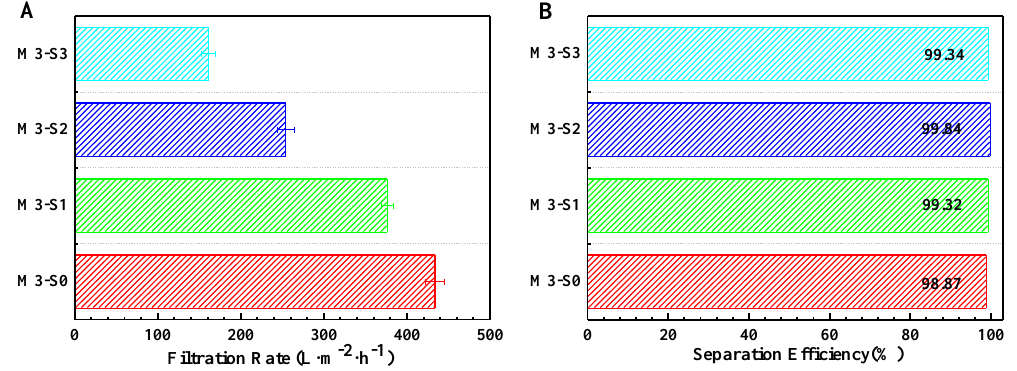
Figure 7. Filtration rate ( A ); and separation efficiency ( B ) for surfactant-stabilized water-in-oil emulsion of the PVDF-HFP hybrid membranes.